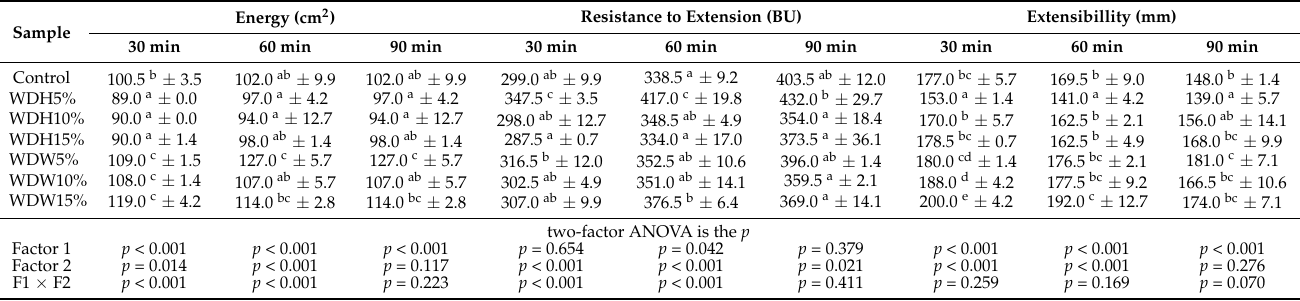
Table 2. Extensographic properties of the tested wheat doughs with the addition of nut flour.